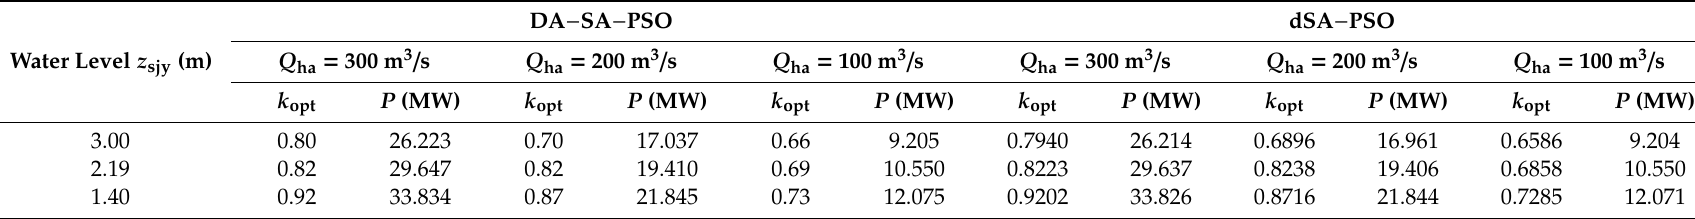
Table 9. Optimal discharge ratio and input power based on dichotomy approach–simulated annealing–particle swarm optimization (DA − SA − PSO) and double-layer simulated annealing–particle swarm optimization (dSA −